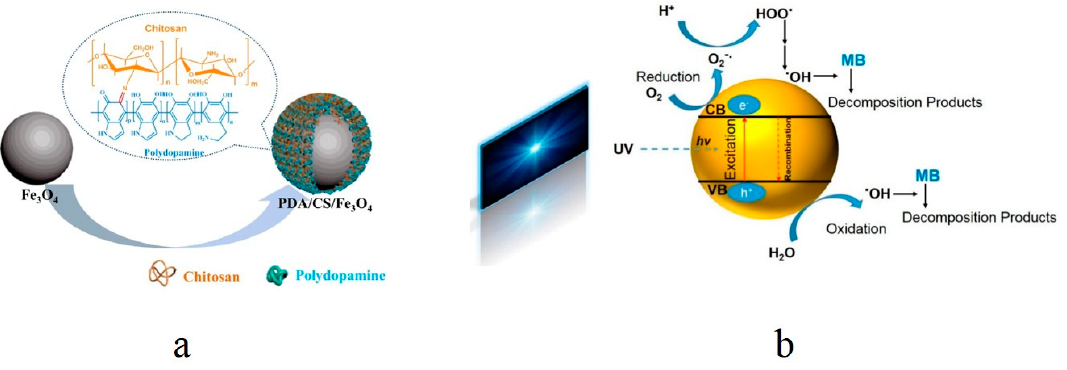
Figure 4. ( a ) A nanocomposite adsorbent comprising polydopamine / chitosan / magnetite nanoparticle core. Reproduced with permission [64]. Copyright 2016, Elsevier. ( b ) The schematic illustrates the photocatalysis process of TiO 2 engendering the dissociation of the neighboring MB molecules. Reproduced with permission [67].